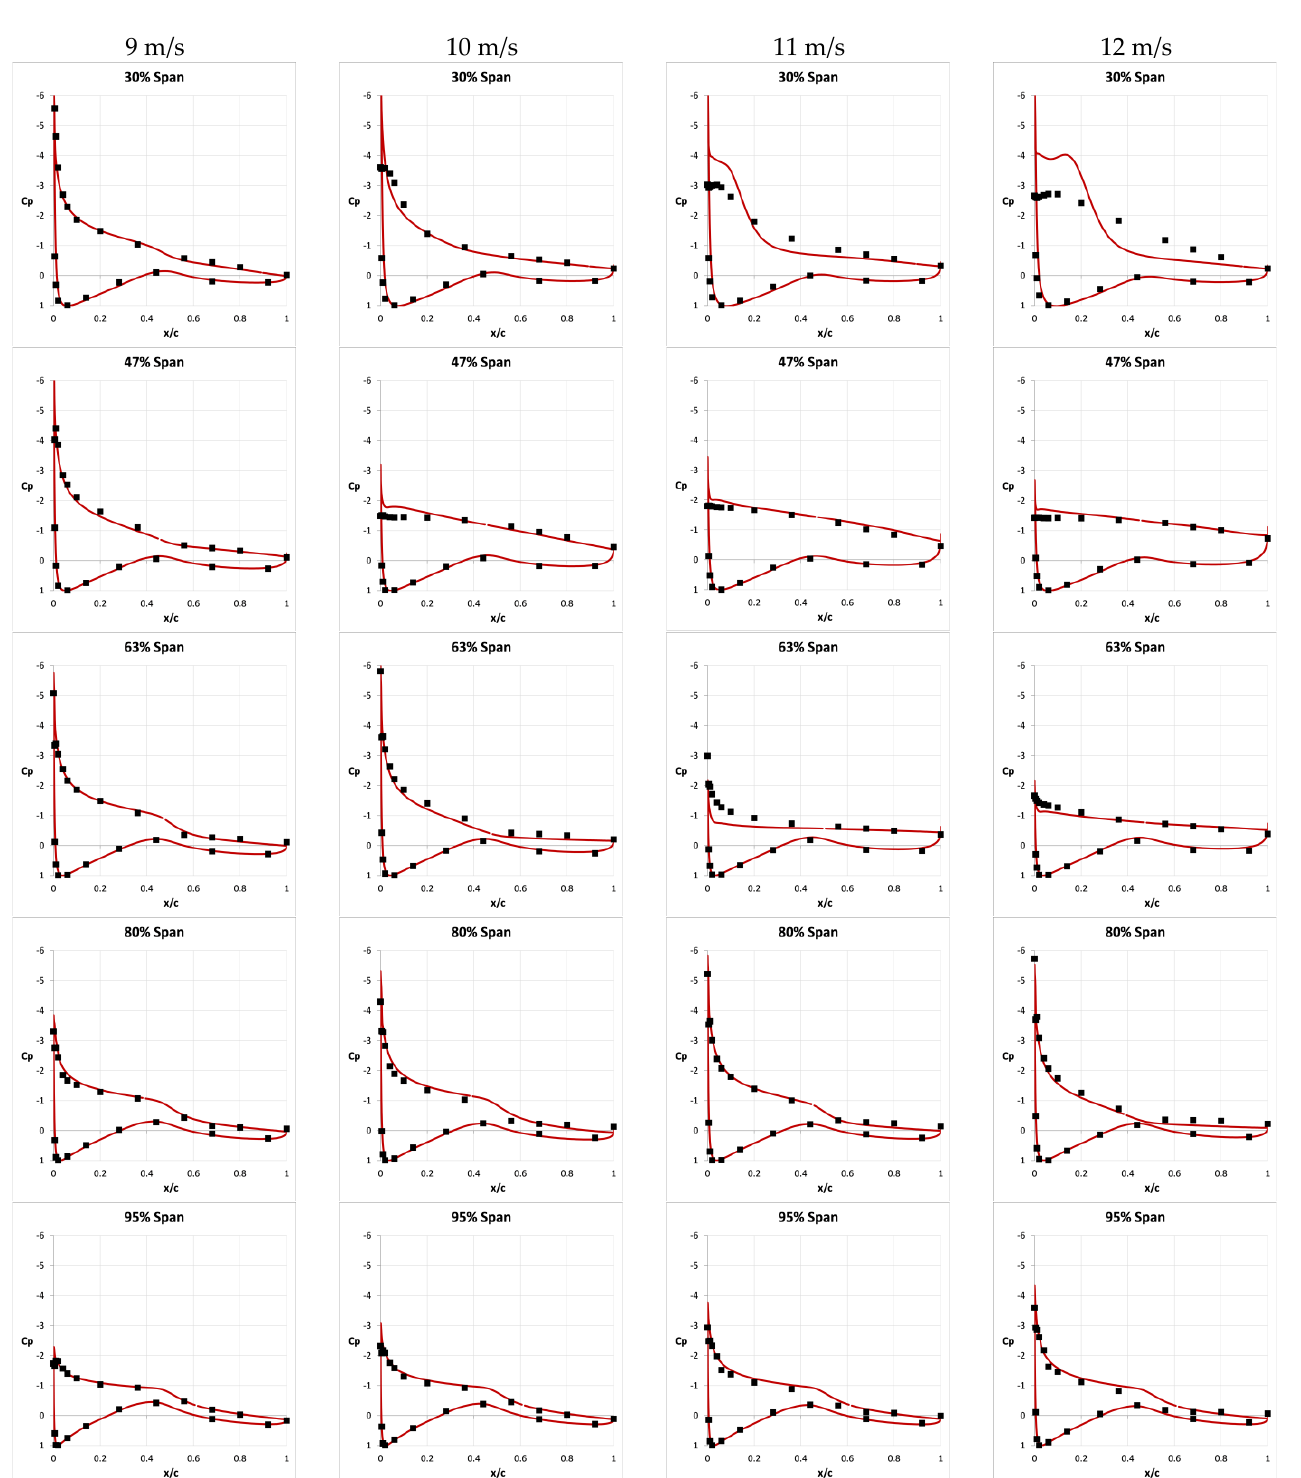
Figure 15. Pressure coefficient distribution vs. measured data between 9 and 12 m/s wind velocities. Each column represents a wind speed; data extracted at five radial stations. Experimental data is represented as black squares and numerical data is drawn as red curves.